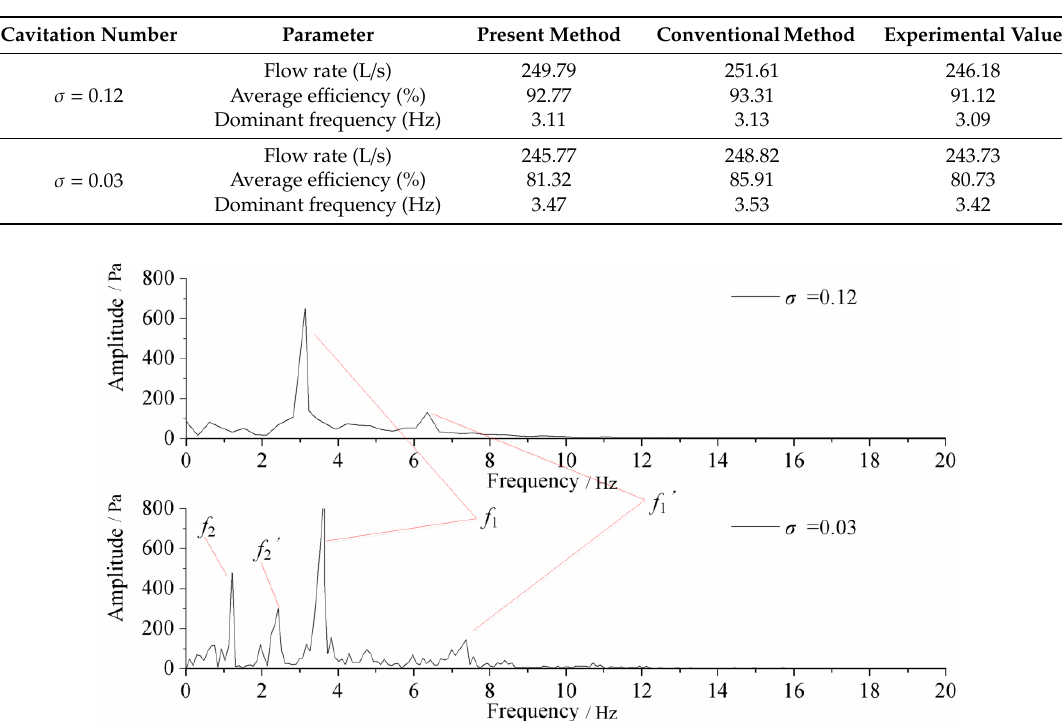
Figure 3. Pressure fluctuations of monitor point P1.